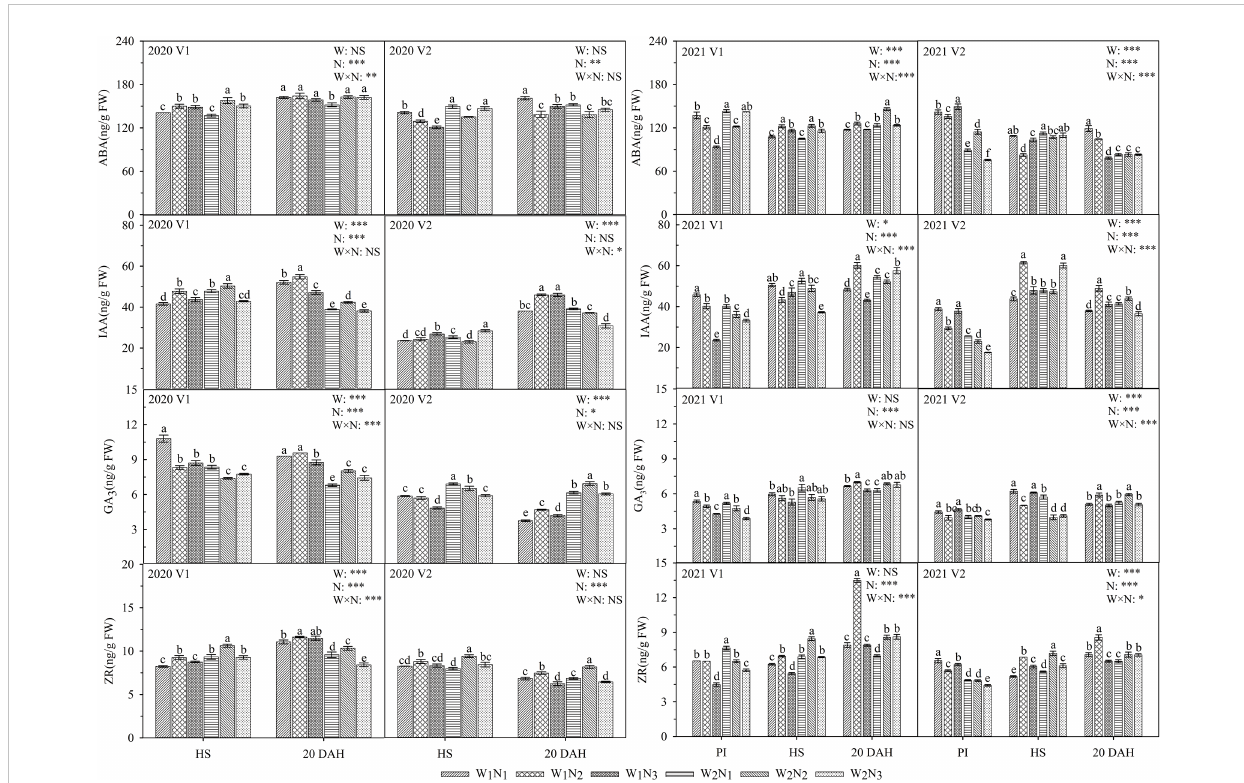
FIGURE 6 Effects of different water and nitrogen treatments on endogenous hormones in rice leaves at different growth stages. The data are presented as the means of three replicates (n = 3). Error bars indicate standard error (SE). W 1 and W 2 represent limited irrigation (10200 m 3 ·hm -2 ) and de fi cit irrigation (8670 m 3 ·hm -2 ), while N 1 , N 2 , and N 3 represent different ratios of seedling fertilizer:tillering fertilizer:panicle fertilizer:grain fertilizer (30%:50%:13%:7%; 20%:40%:30%:10%; and 10%:30%:40%:20%, respectively). PI, HS, and 20 DAH represent panicle initiation, heading stages, and 20 days after heading, respectively. V1 and V2 represent T-43 and Liangxiang-3, respectively. * represents a signi fi cant difference at the 0.05 level; ** represents a signi fi cant difference at the 0.01 level; *** represents a signi fi cant difference at the 0.001